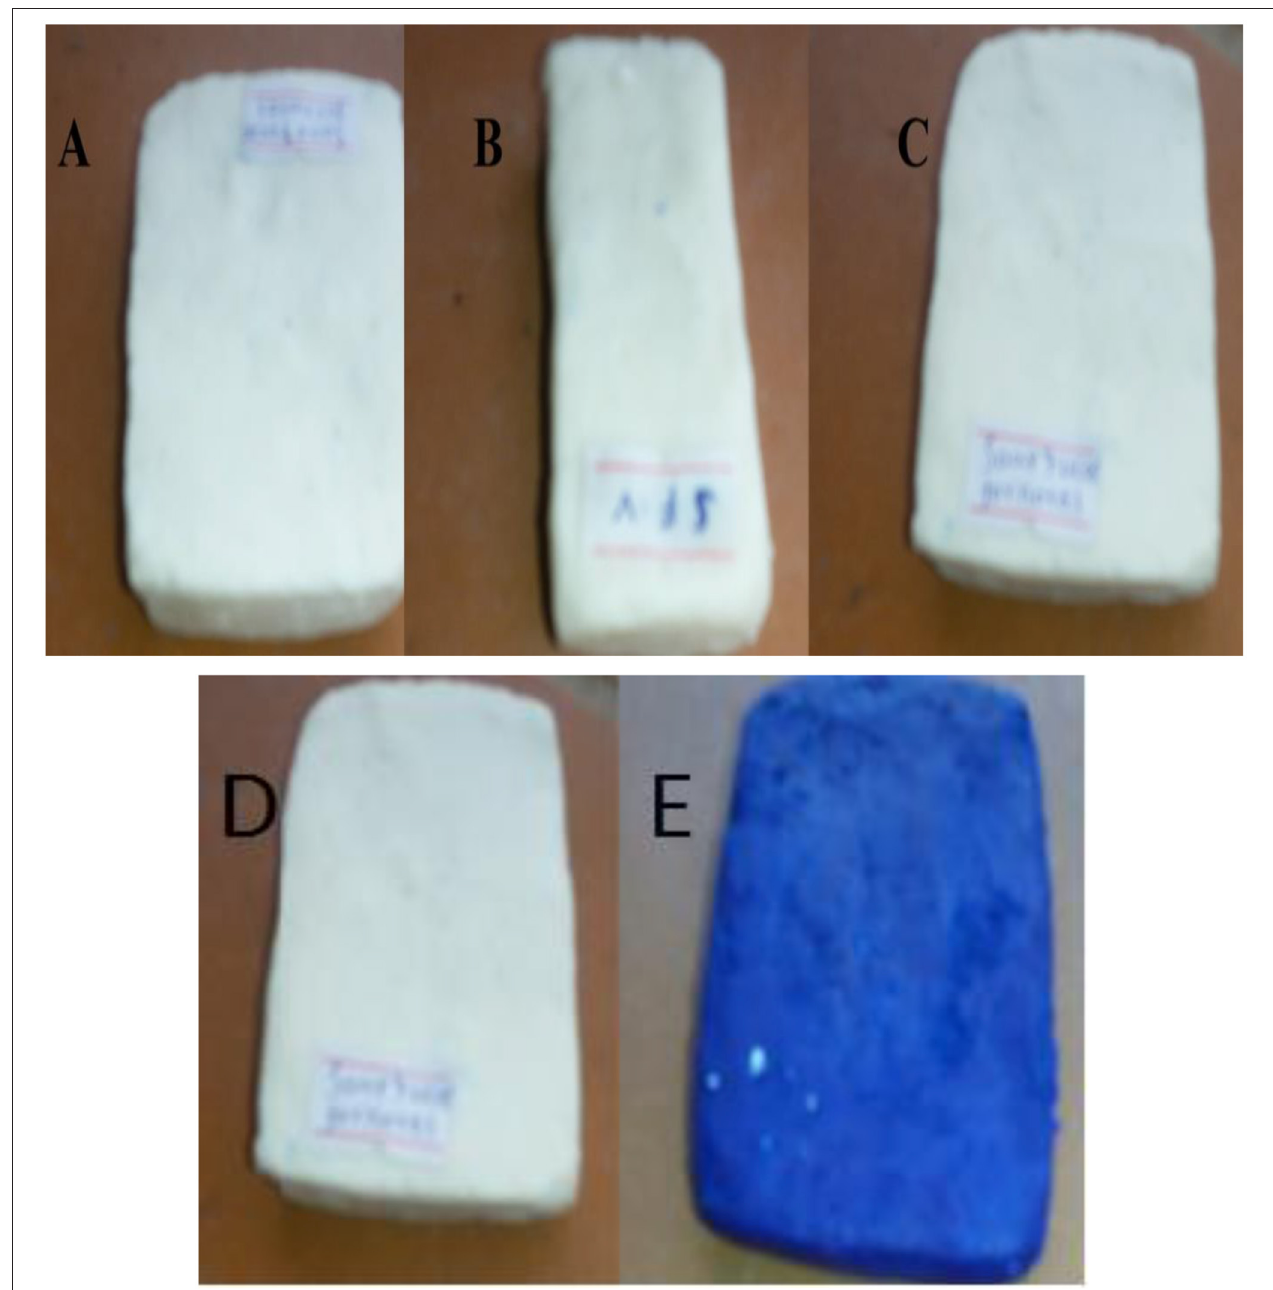
FIGURE 7 | The laundry soaps from oil samples obtained from hotel (A) , street food vendors (B) , blend of hotel and a street food vendors (C) , blend of hotel and a street food vendors with additive (D) , and blend of hotel and a street food vendors (with colorant) (E) .